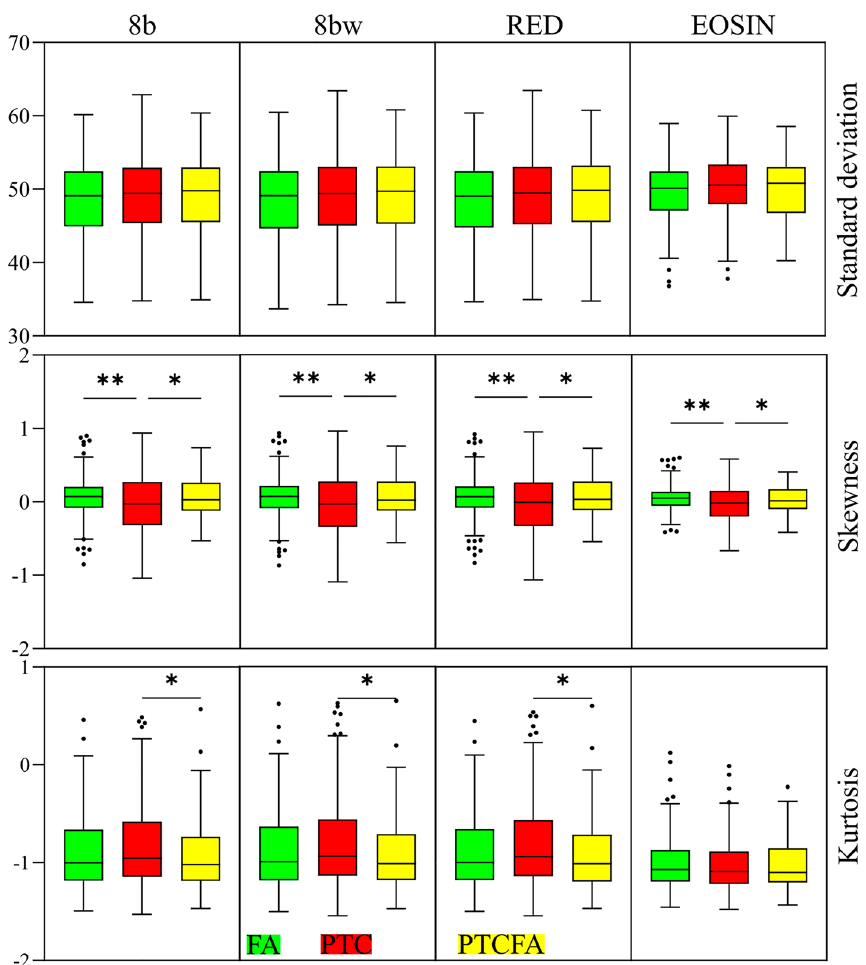
Figure 7. Statistical analysis for the case of Helmholtz analysis parameters extracted from the 1024 × 1024 pixels image tiles. (* p < 0.05, ** p <